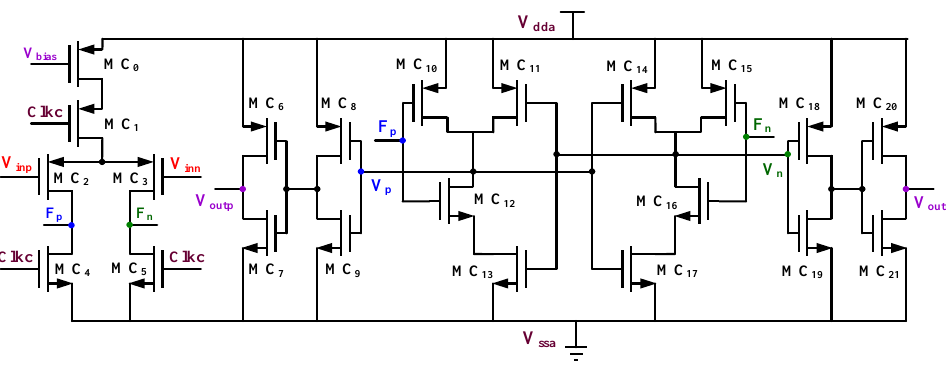
Figure 9. Detailed circuit of the modified two-stage dynamic comparator.